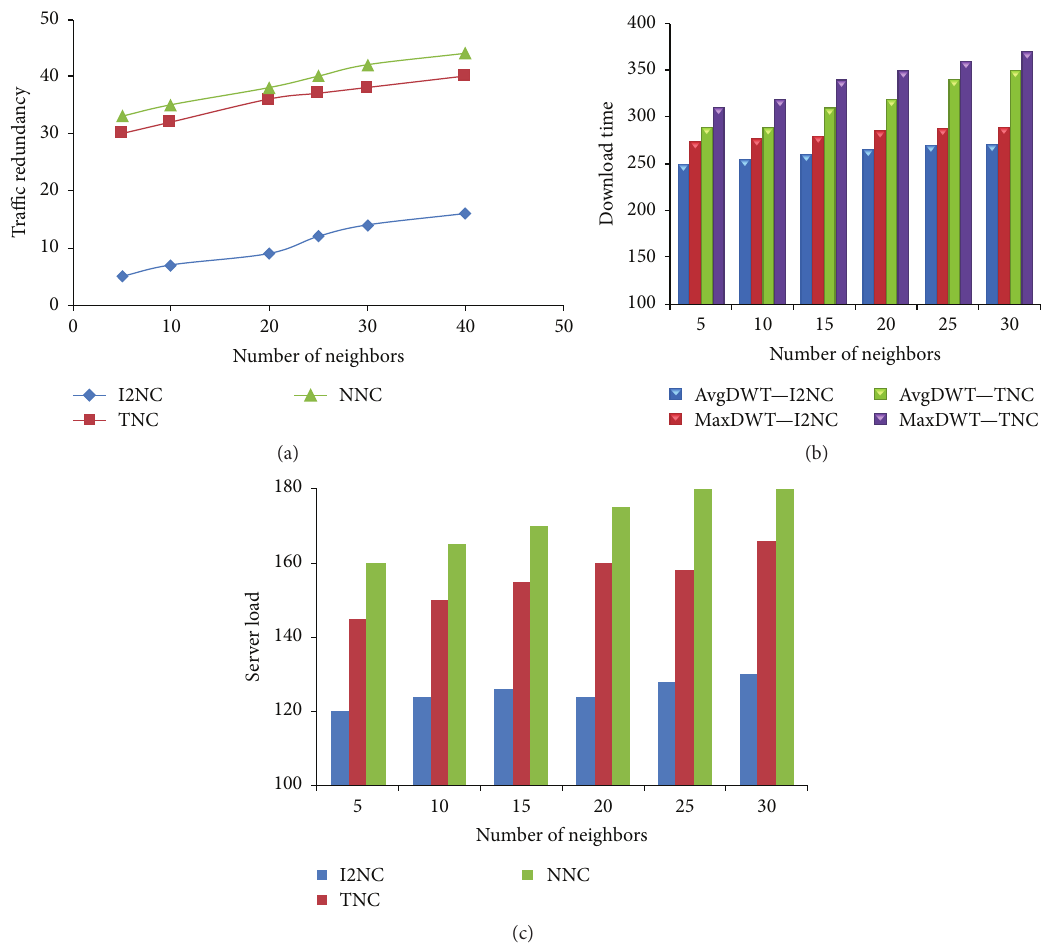
Figure 6: (a) Traffic redundancy. (b) Packet distribution time. (c) Server’s